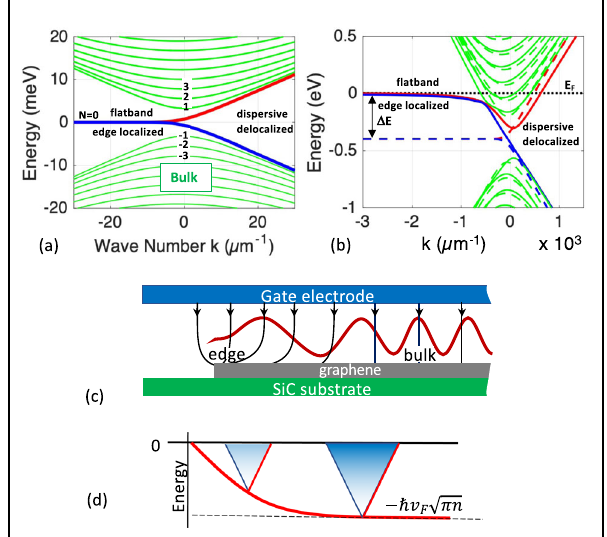
Fig.1|Theepigrapheneedgestate.a Tightbindingbandstructureofonevalleyof a 740nm wide zigzag graphene ribbon that consists of the hyperbolic bulk 1D subbands and the edge state.Theedgestate iscomposedof a fl atband at E=0that is localized at the ribbon edge and that merges into two delocalized linear dis- persing bands. Original theory predicted that the delocalized branches of the N =0 subband is a protected edge state for energies between the N =±1 bulk subbands 40 . b Tightbindingbandstructurewherethe fl atbandatenergy E =0pins the Fermi level E F at E =0 at the edge. Charges induced near the edge will be depleted by the fl atband to produce a Schottky barrier between the edge and the bulk.Theresultingelectric fi eldscausebandbendingsothattheDiracpointwillbe ffiffiffiffiffiffiffi p π n below the Fermi level, as schematically depicted in ( d ). c Schematically at _ v F shows the divergence of the Fermi wavelength at the